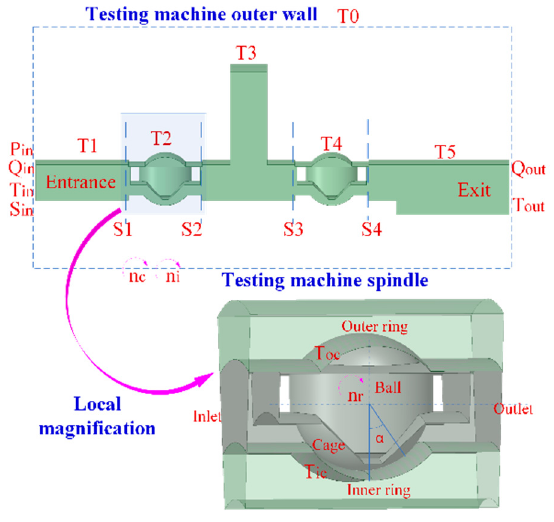
Figure 21. Ultra-low temperature ball bearing testing machine.